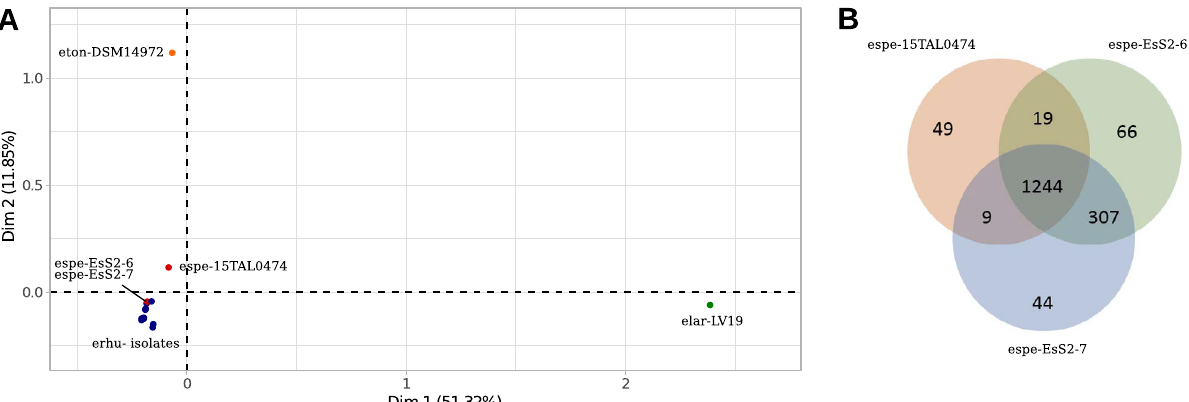
Figure 4. Pan-genome analysis of the genus Erysipelothrix and of E. sp. Strain 2 isolates. Legend: ( A ) Multiple correspondence analysis (MCA) of the genus Erysipelothrix pan-genome. Species mentioned in the figures are described in Supplementary Table S1. Blue dots belong to E. rhusiopathiae isolates. Red dots belong to E. sp. Strain 2 isolates. ( B ) Venn diagram of E. sp. Strain 2 pan-genome. Number of orthologous groups (OGs) that belong to the core genome (shared among the three isolates—union of all circles), number of accessory OGs (shared between two isolates—intersection of two circles), and number of singletons (exclusive/unique genes— remaining area of each circle) are